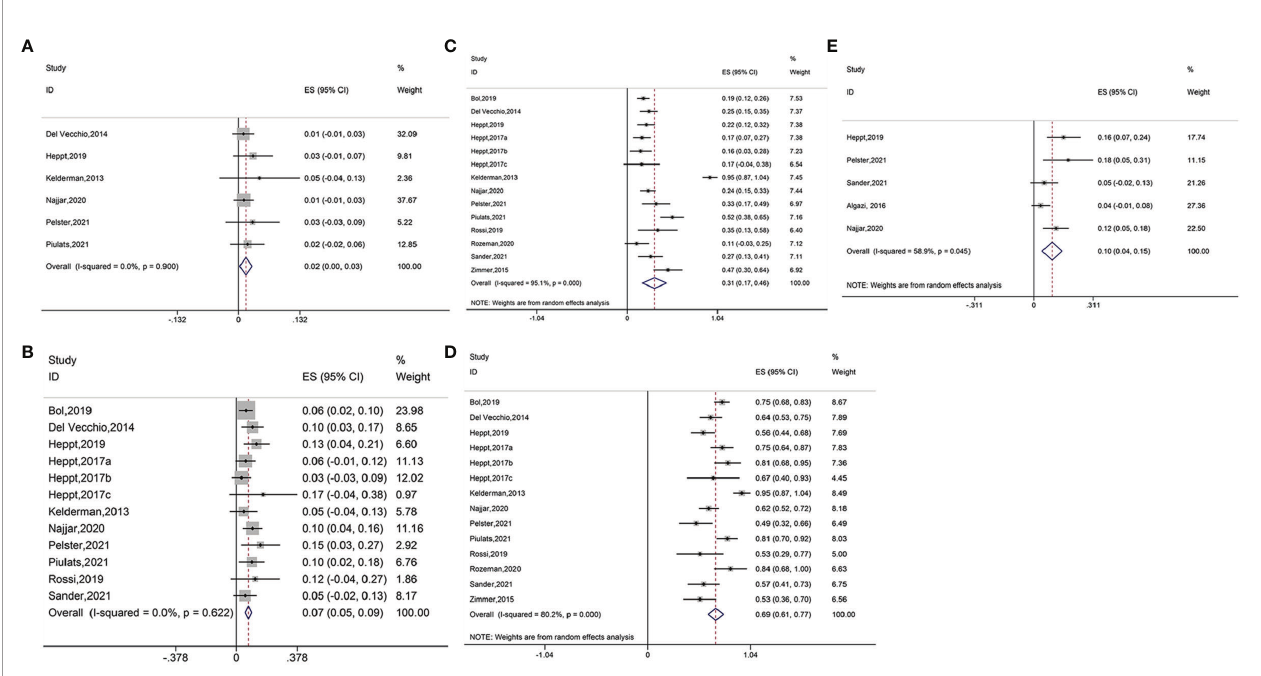
FIGURE 2 | (A) Forest plot of complete response (CR) with immune checkpoint blockade treatment. (B) Forest plot of partial response (PR) with immune checkpoint blockade treatment. (C) Forest plot of stable disease (SD) with immune checkpoint blockade treatment. (D) Forest plot of progressive disease (PD) with immune checkpoint blockade treatment. (E) Forest plot of objective response rate (ORR) with immune checkpoint blockade